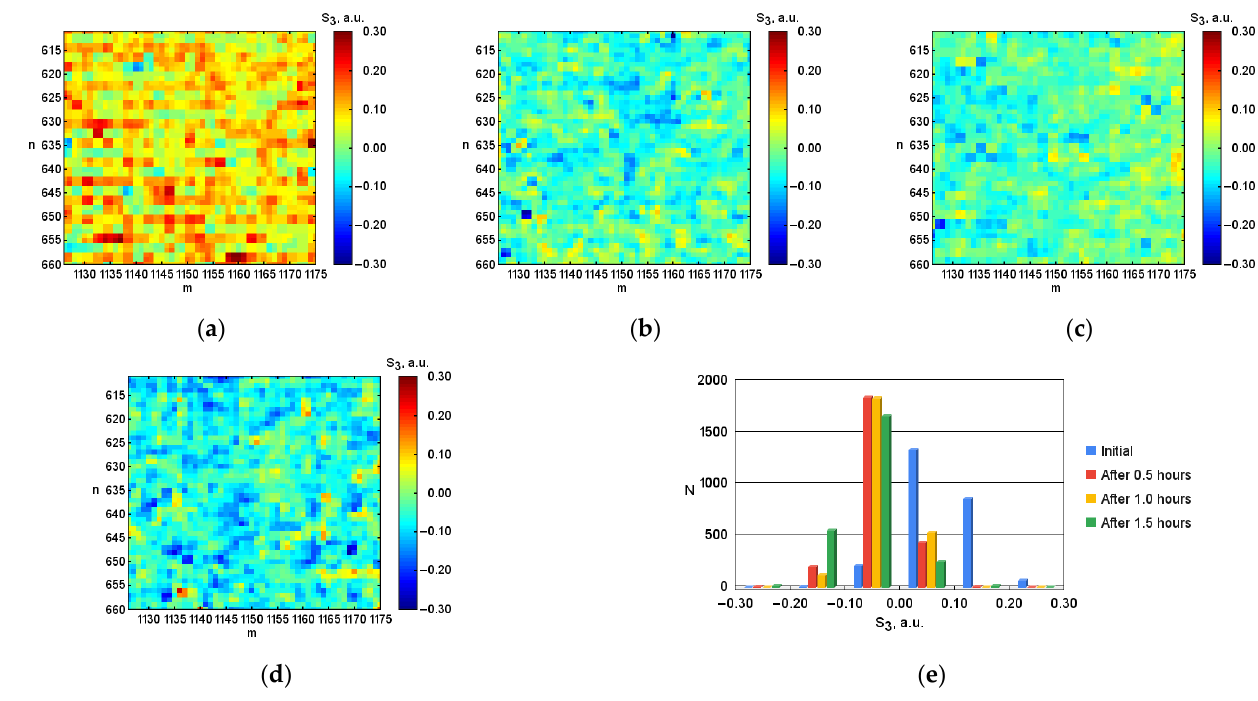
Figure 5. Coordinate distributions of the parameter of the Stokes vector S 3 , where: ( a ) is the initial hematocrit level; ( b ) is the hematocrit level after 0.5 h; ( c ) is after 1.0 h; ( d ) is after 1.5 h, and ( e ) the corresponding histograms of the object under investigation.